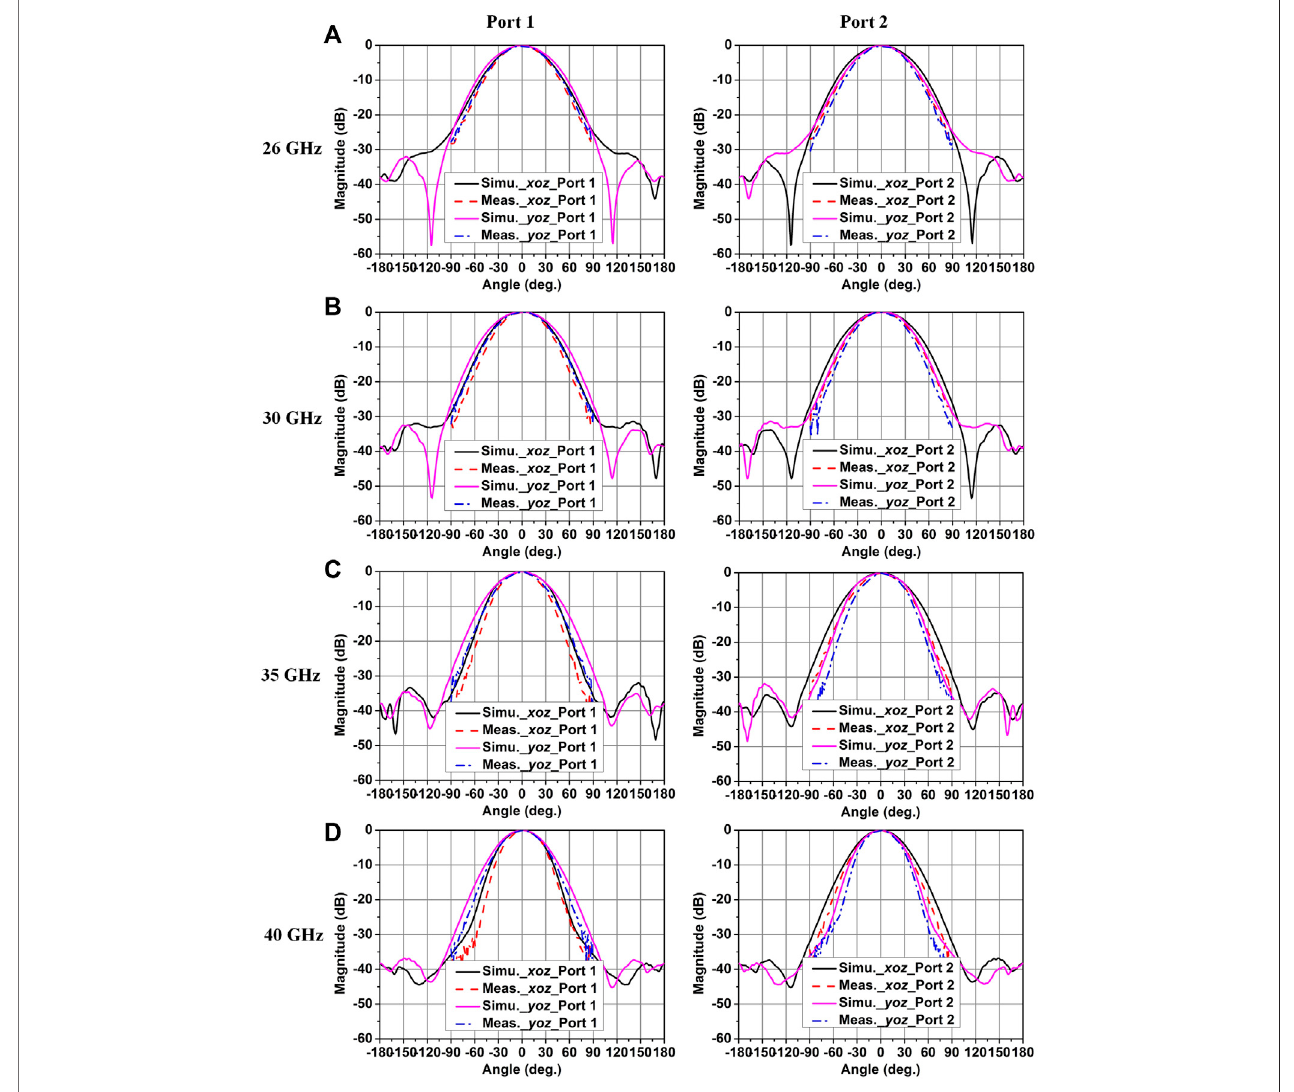
FIGURE 10 | Simulated and measured radiation patterns of the dual-polarized horn antenna with OMT at (A) 26 GHz. (B) 30 GHz. (C) 35 GHz. (D) 40 GHz.